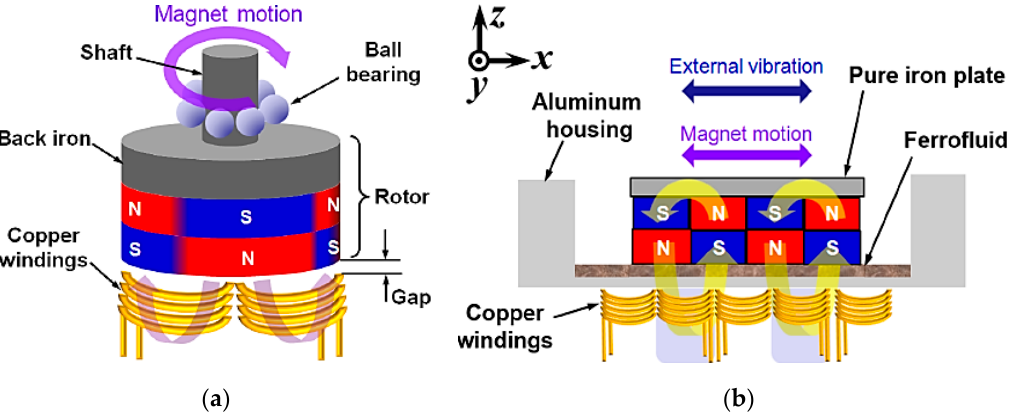
Figure 4. Structure electromagnetic vibration generator: ( a ) flux generator, ( b ) structure of the linear vibration-based energy harvesting [41,42].